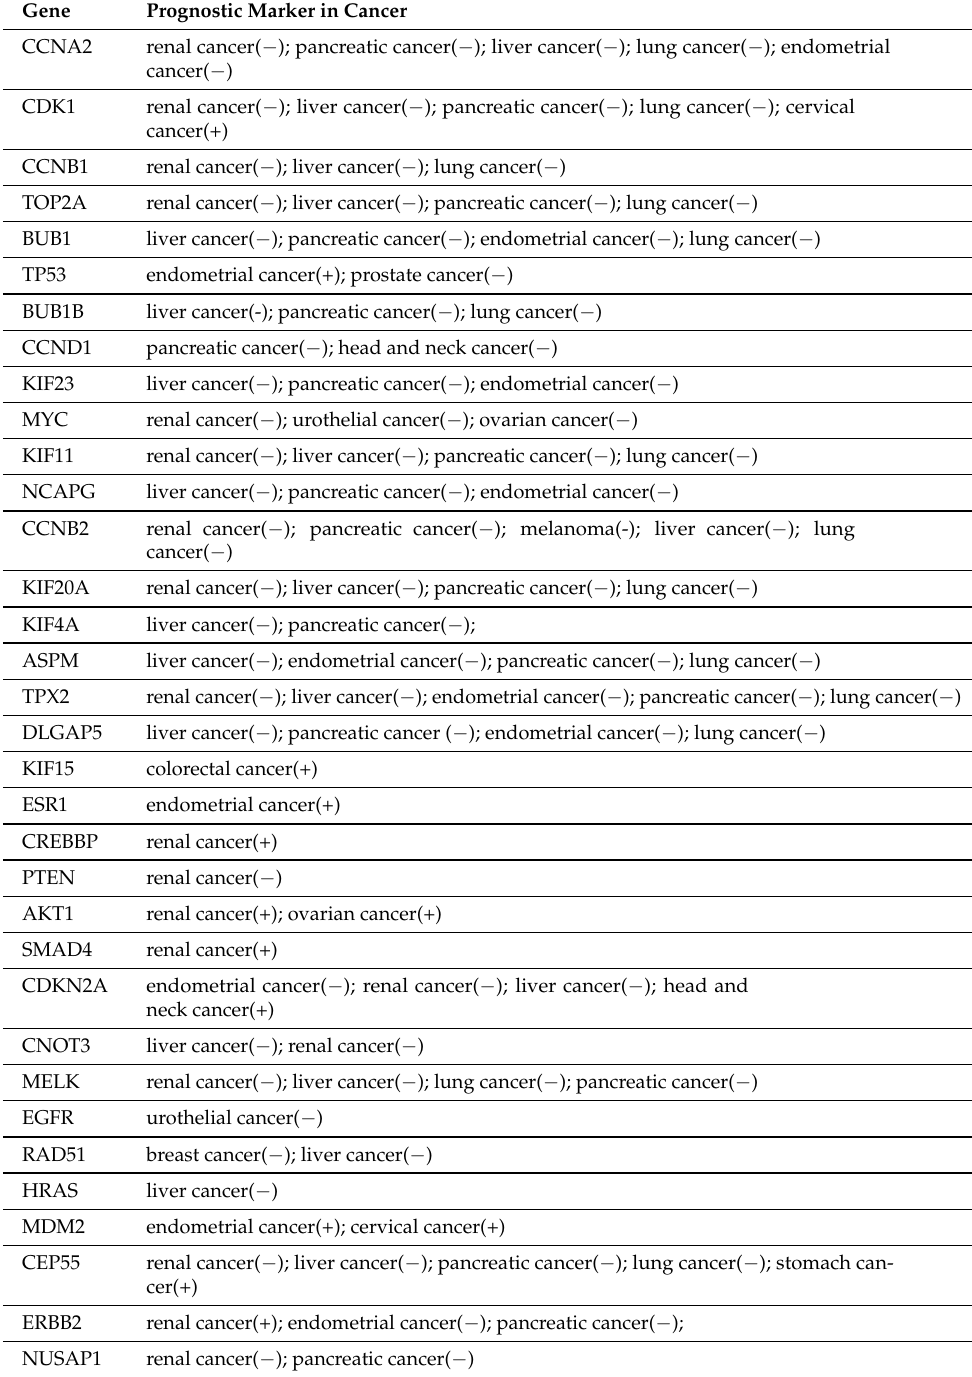
Table 3. Prognostic marker information in cancer tissue of the top 20